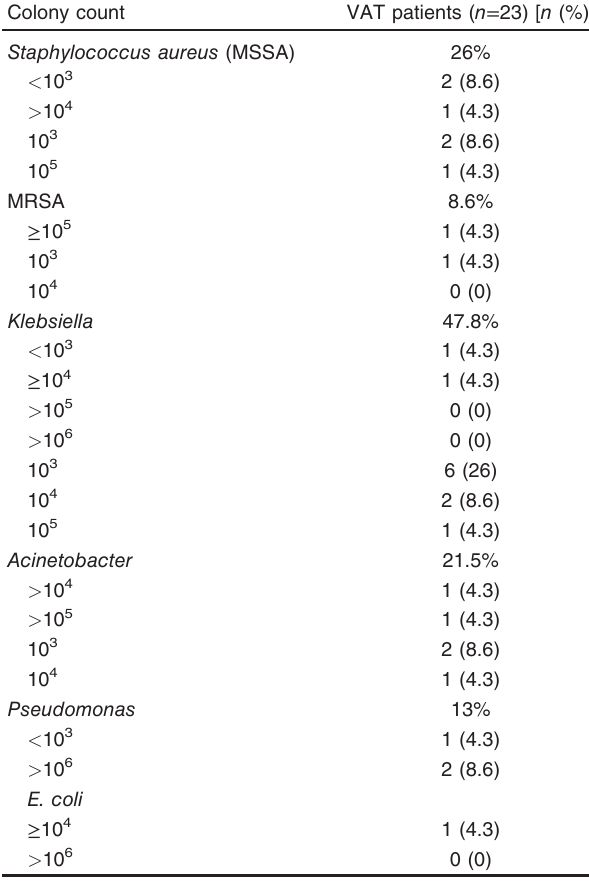
Table 5 The bacteria isolated from the ventilator-associated tracheobronchitis patients and their colony count Colony count VAT patients ( n = 23) [ n (%)] Staphylococcus aureus (MSSA)